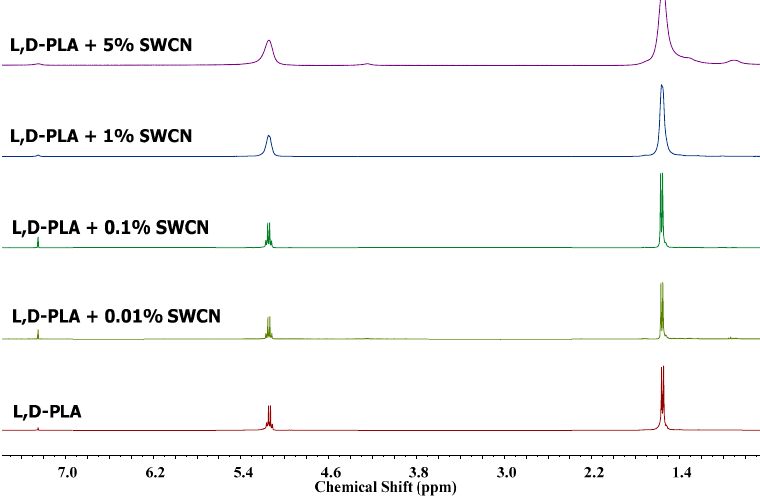
Figure 16. 1 H NMR spectra of pure L , D -PLA and its mixtures with